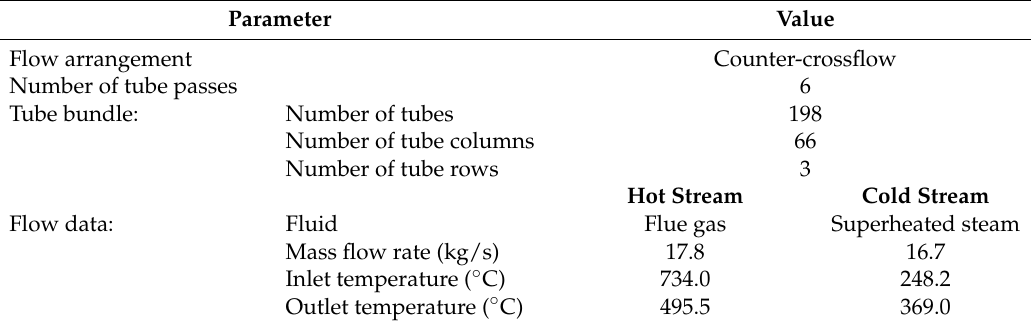
Figure 4. Tube bundle of the final steam superheater; an orange colouration is a distinctive feature of the accumulated corrosion layer. Grey and black deposits of flue gas components are highly visible between tubes. Table 1. General parameters of the final steam superheater.